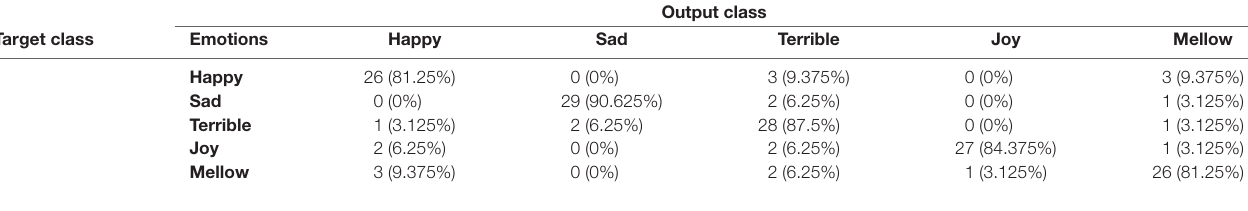
TABLE 8 | Confusion matrix for five emotional